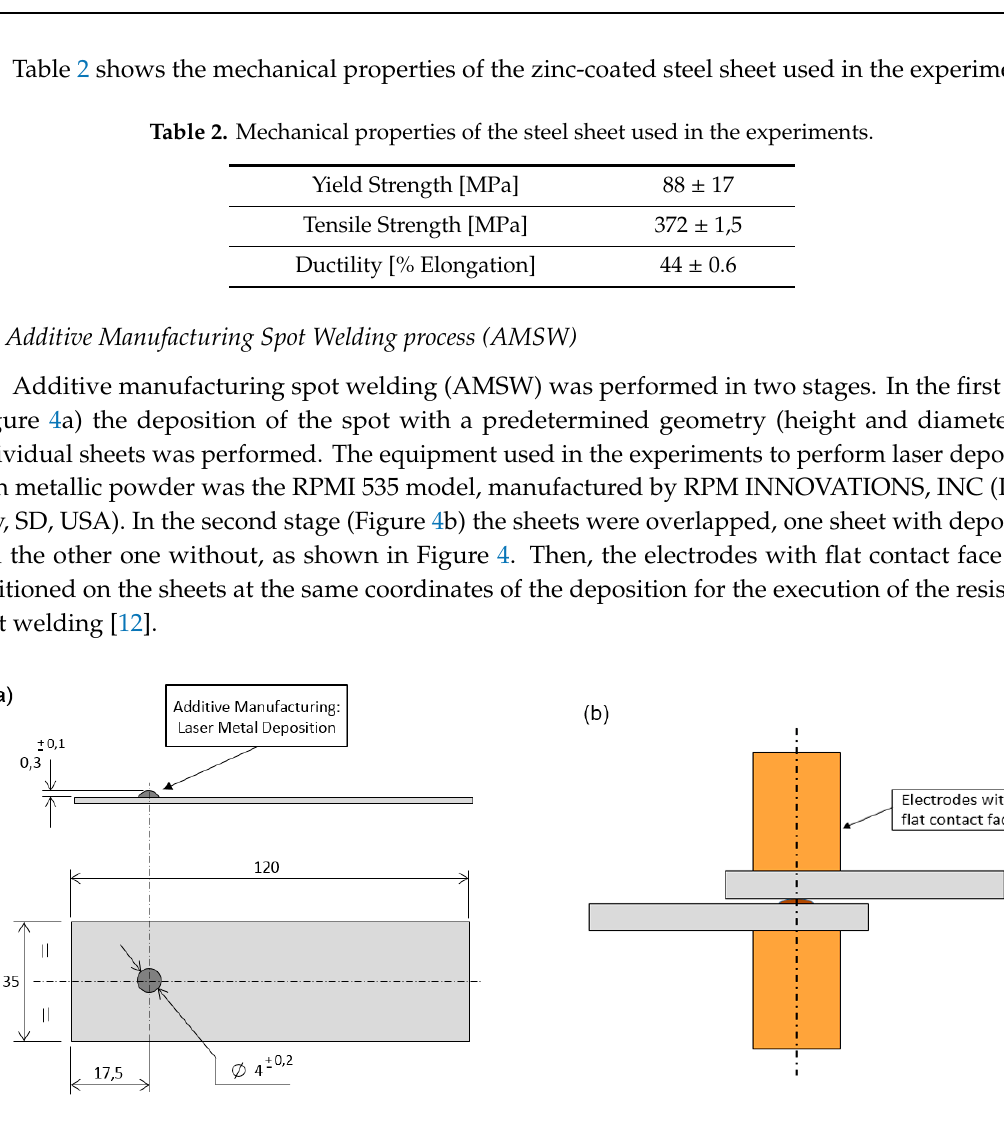
Table 1. Chemical composition of the steel sheet used in the experiments.